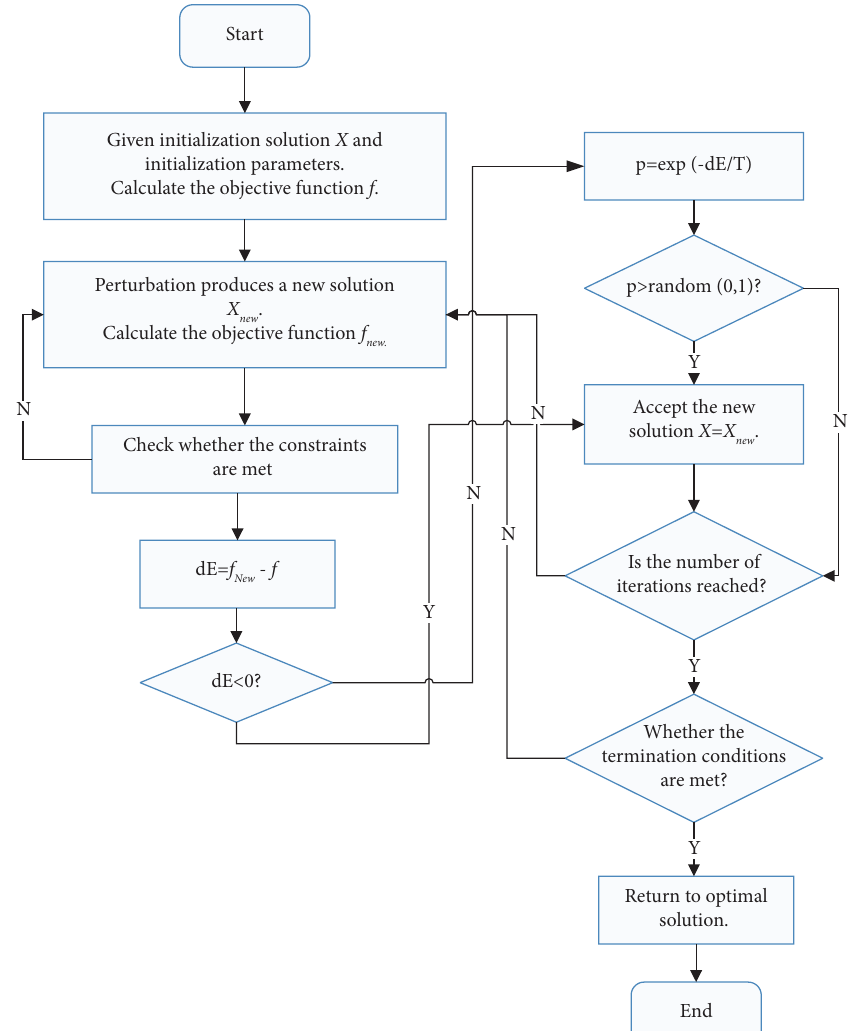
Figure 2: Flowchart of simulated annealing